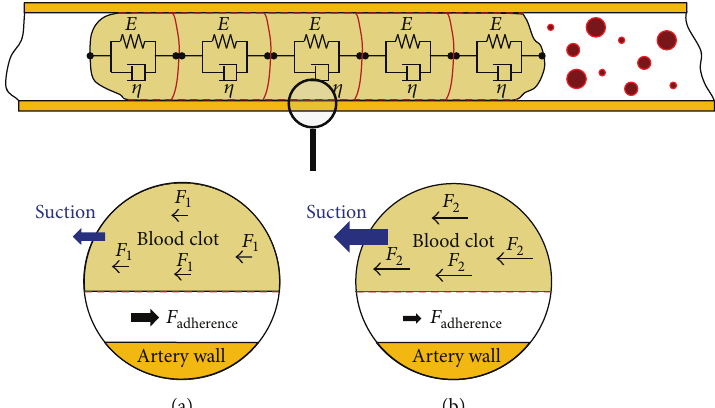
Figure 7: Adherence and friction based on effort source. (a) Lower suction force; no movement. (b) Suction force higher than adherence force.